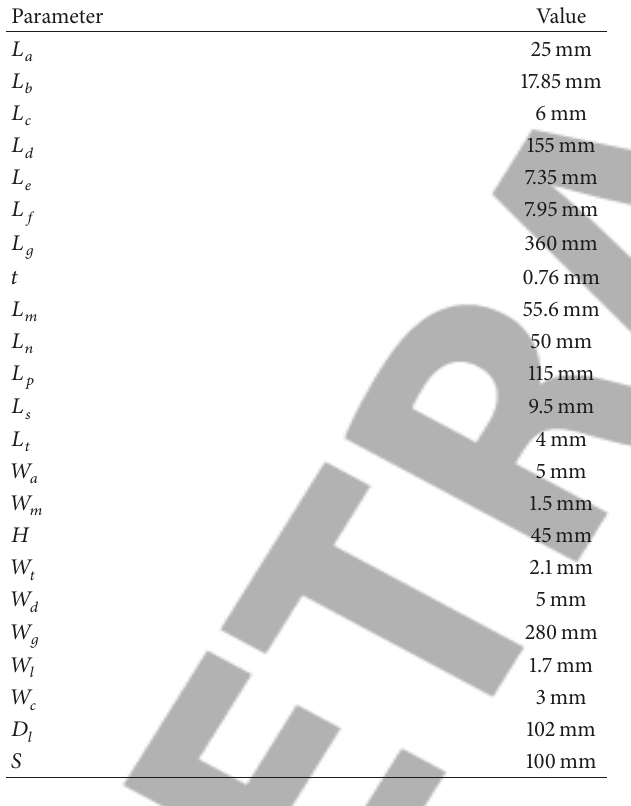
Table 1: Size Parameters of